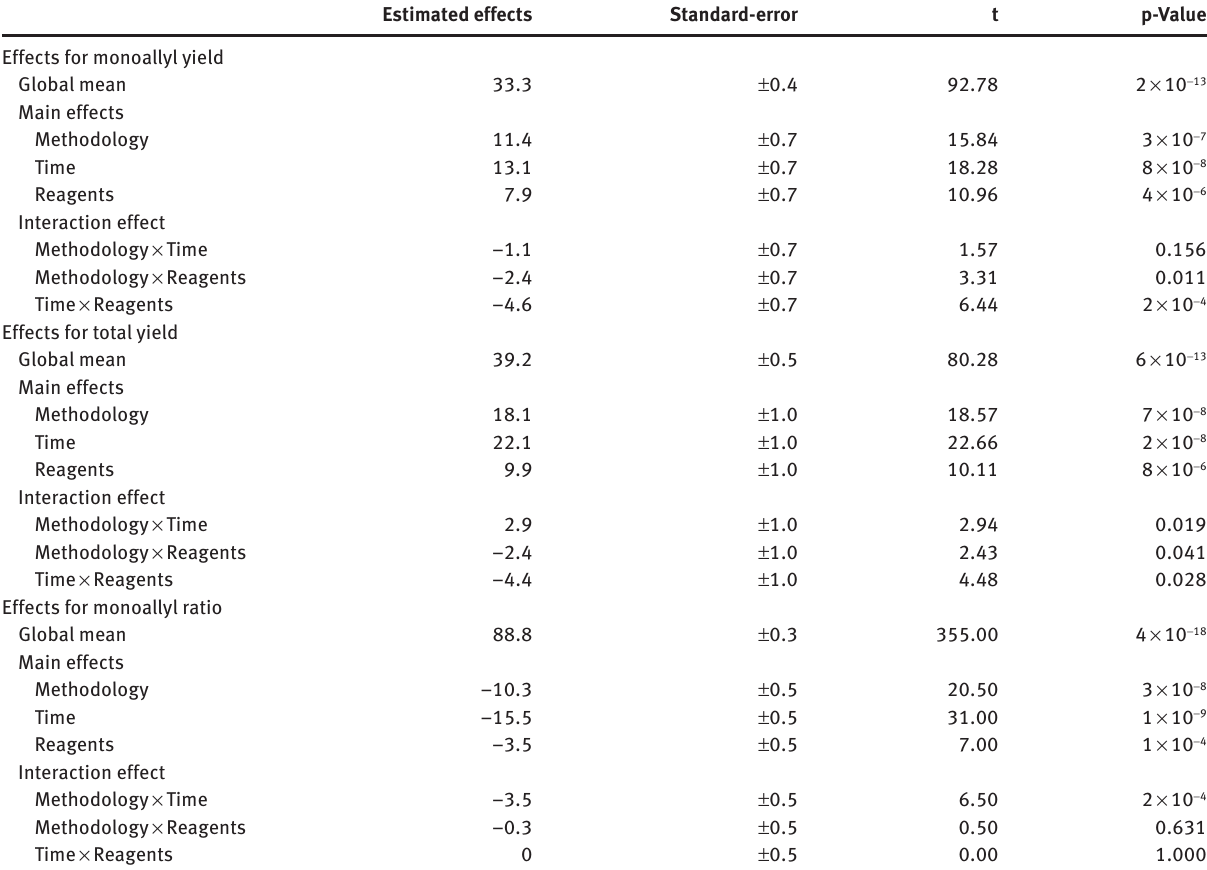
Table 4: Calculated effects for each factor in the transposition to US